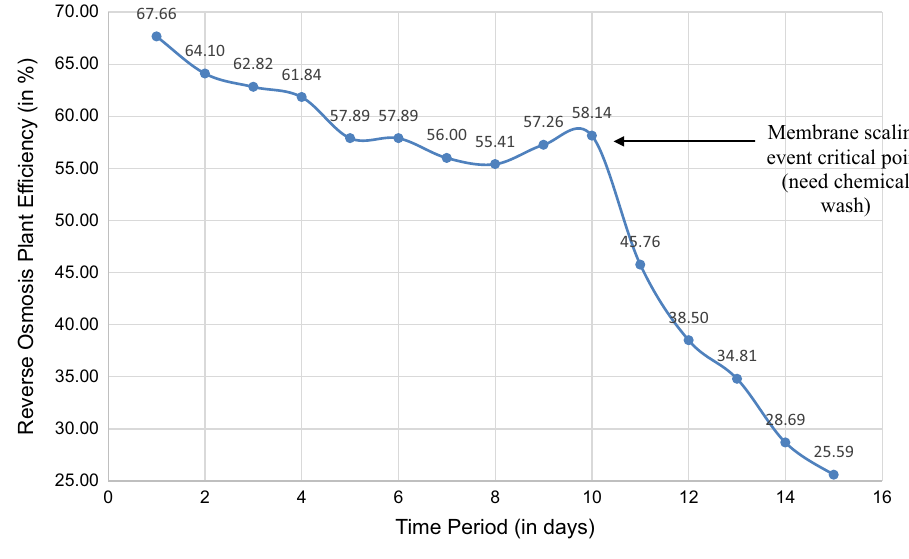
Fig. 7 Efficiency analysis of reverse osmosis membrane over the time period of 15